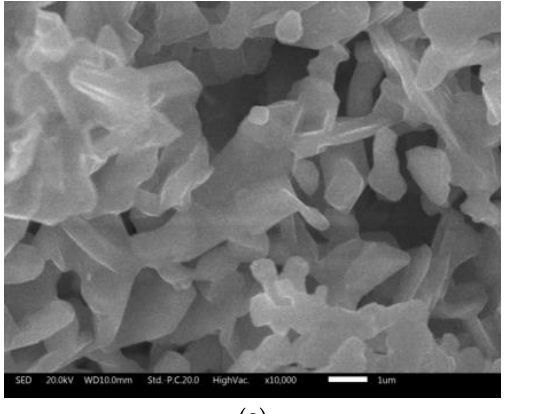
Table 2. Calculated crystallite size of double perovskite from SGA and SGB reference experiments, and those from microwave assisted technique E, F, H, and I. The average values were obtained by the SSP method. The complete statistical data from linear fit is presented in Supplementary Mate- rials Table S1.